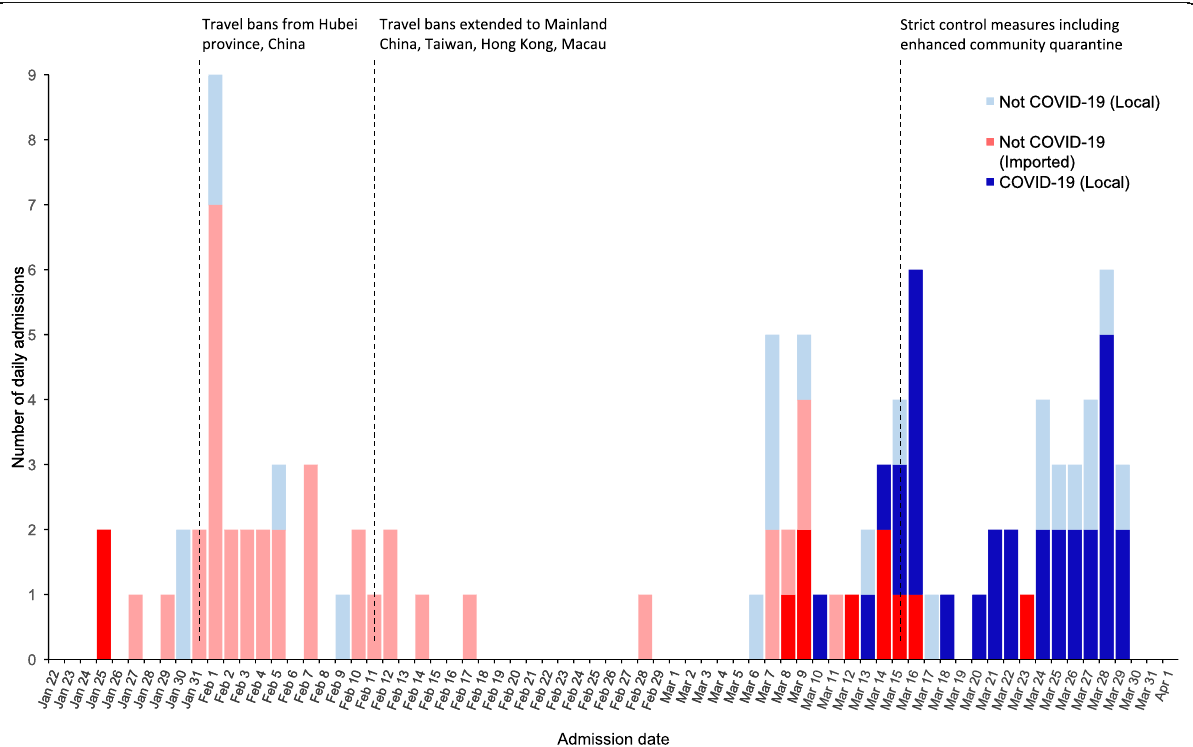
Fig. 1 Timeline of admission date of the first 100 suspected COVID-19 cases to an infectious diseases hospital in Metro Manila. Cases were considered “ imported ” if a history of international travel was reported within 14 days prior to the admission, and conversely ‘ local ’ if